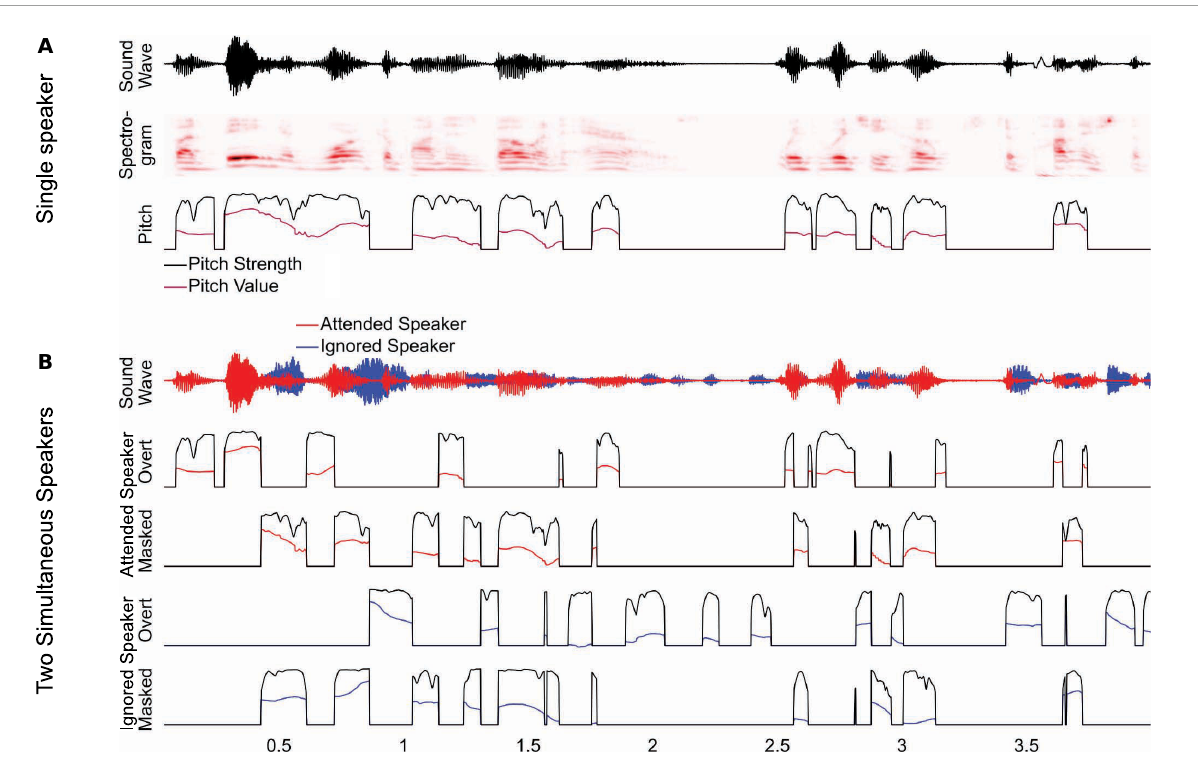
FIGURE1 Predictors for analyzing pitch tracking. (A) For a single speaker, pitch tracking was estimated using two predictors: pitch strength , reflecting the degree to which a distinctive pitch is present in the sound signal, and pitch value , reflecting the fundamental frequency of the pitch, relative to the baseline. For moments when pitch strength is 0, the pitch value is set to the default baseline value. (B) For two-speaker stimuli, pitch strength and value were estimated separately for each speaker and then split into two separate predictors, reflecting overt pitch (i.e., pitch is present only in a single speaker) and masked pitch (i.e., pitch is present in both speakers). Note that, as a consequence of this definition, the two masked pitch predictors are always simultaneous, whereas the overt pitch predictors are mutually